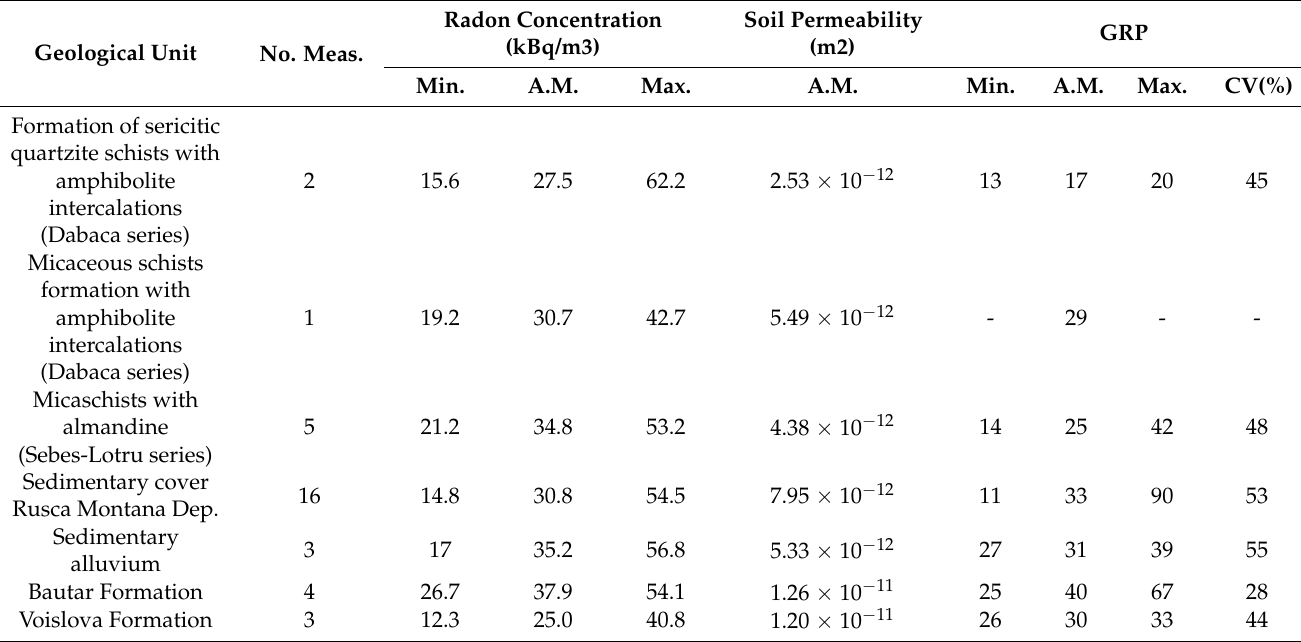
Table 2. The descriptive statistics of radon concentration, soil permeability, and geogenic radon potential in seven geological units, according to the 15-measurement points